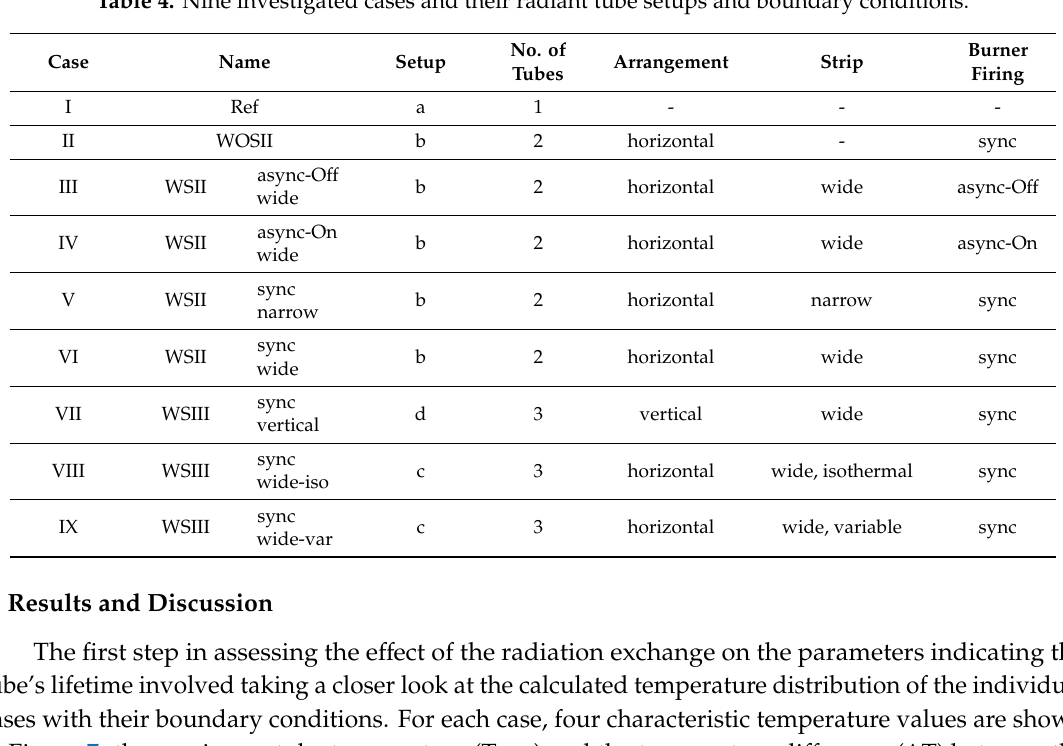
Table 4. Nine investigated cases and their radiant tube setups and boundary conditions.